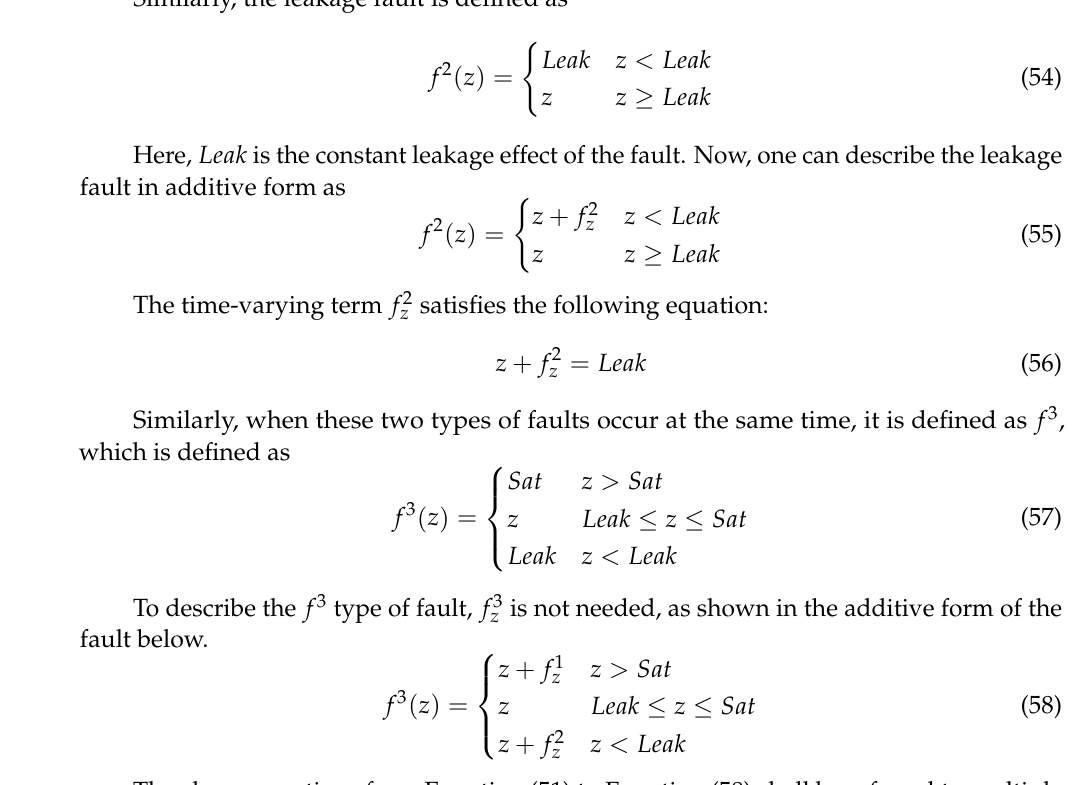
Figure 1. Three-pond hydraulic system.